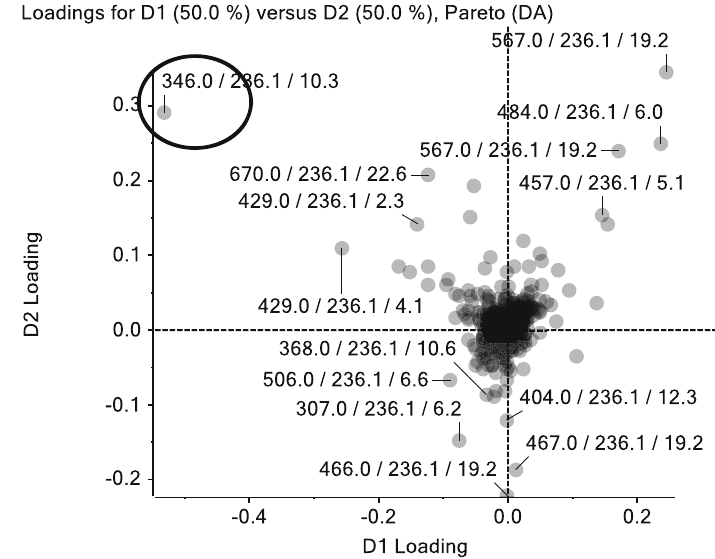
Figure 3: Loading plots of CC - DHs in three outer leaves of fresh cabbage.